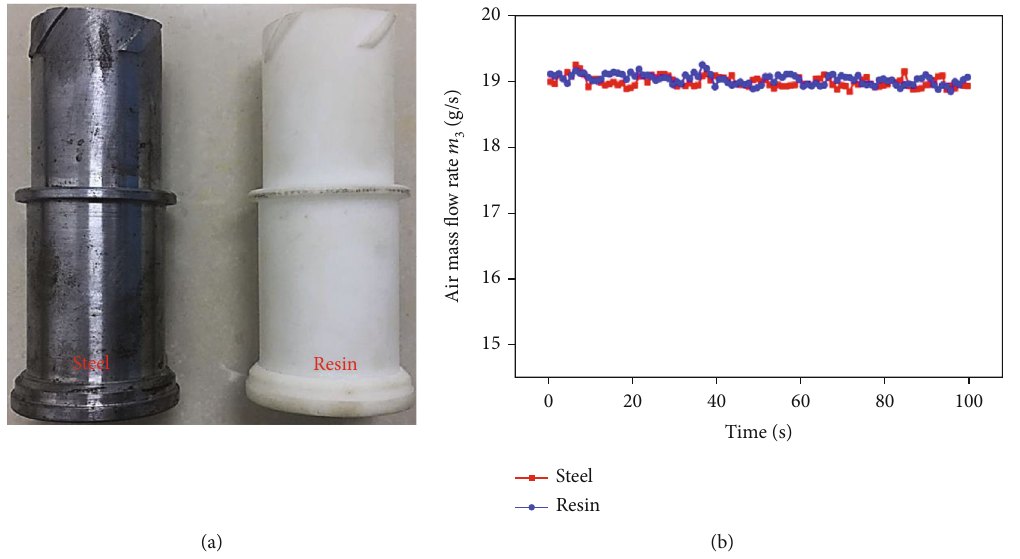
Figure 7: Swirler material test. (a) Swirler; (b) testing